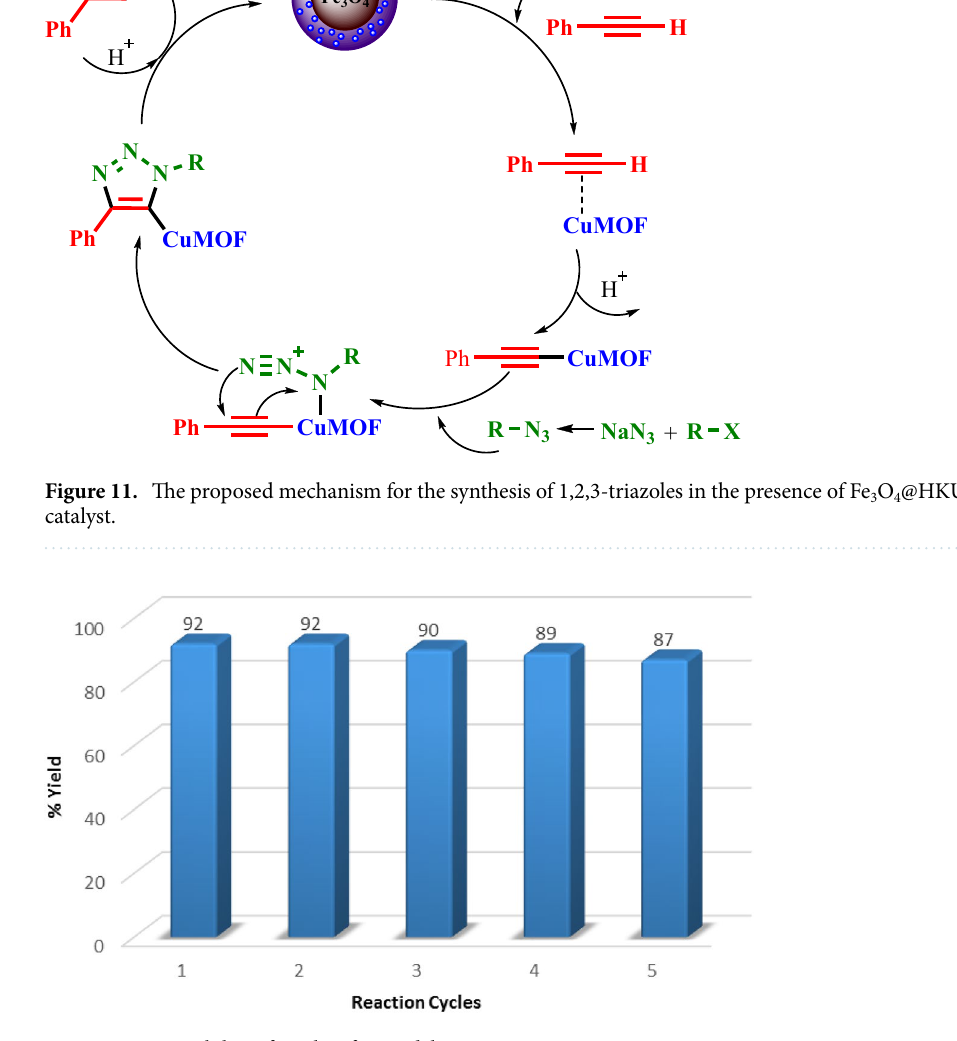
Figure 12. Reusability of catalyst for model